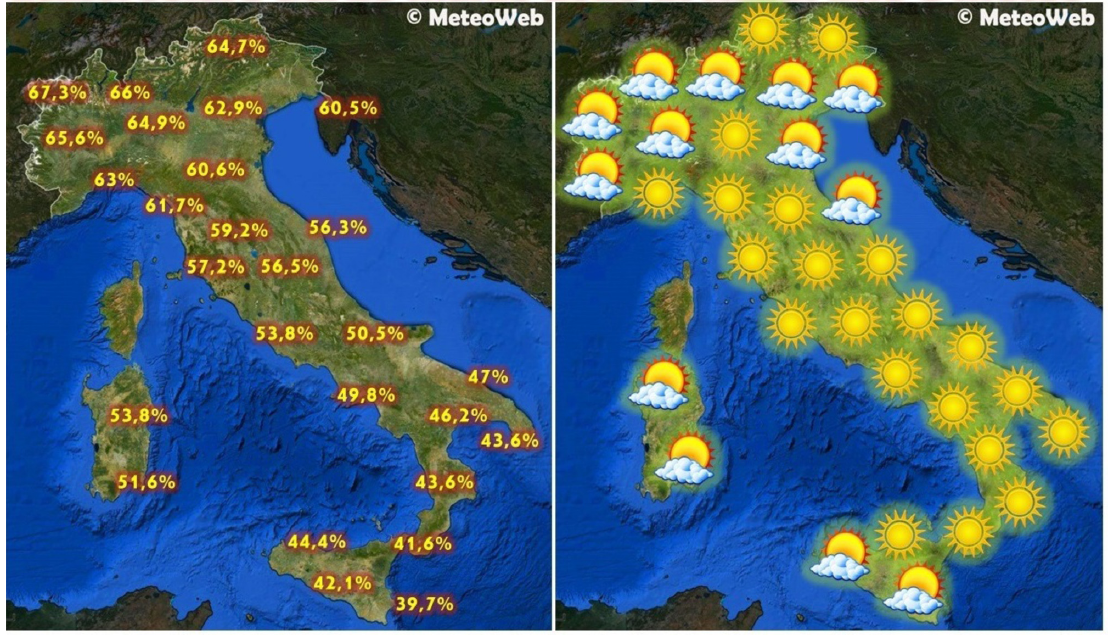
Figure 2. (Left) Percent of the Sun’s dimming (see also Table 1), and (Right) meteorological conditions in Italy on March 20, 2015. Figure from